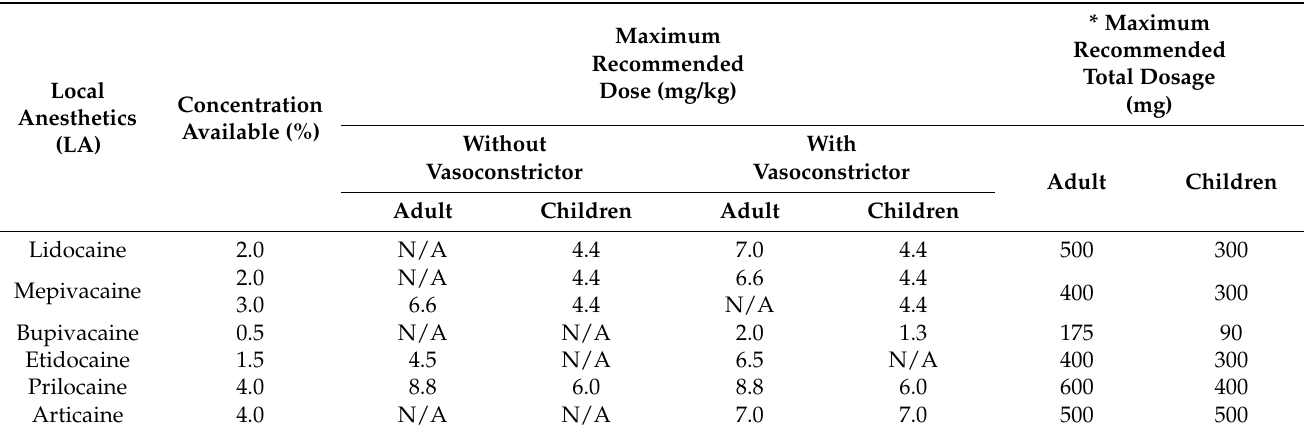
Figure 2. Common chemical structure of parabens. Table 2. Chemical structure of different parabens.